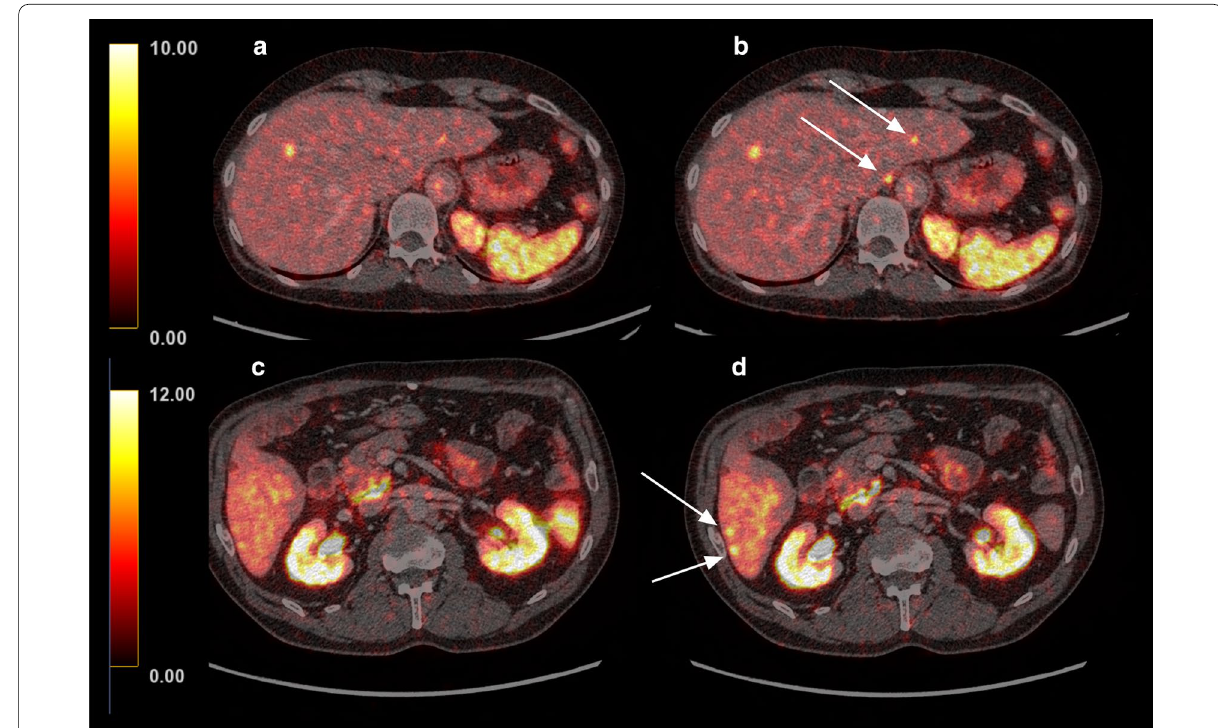
Fig. 3 Fused [ 68 Ga]Ga-DOTATOC PET/CT images in the transverse plane of two patients with small-intestinal neuroendocrine tumours in the upper panel ( a , b ) and in the lower panel ( c , d ), respectively. Non-gated images are shown to the left ( a , c ) and the gated images to the right ( b , d ). In each patient, two additional lesions were diagnosed in the gated image (indicated by